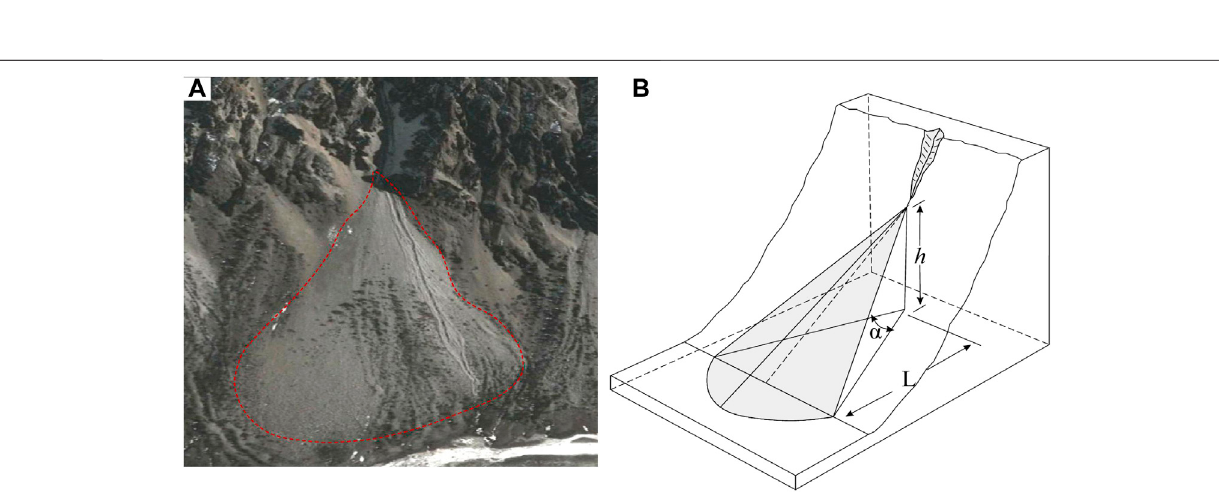
FIGURE 5 | The accumulation morphology and geometric model of triangular prismatic moraines. (A) Field image. (B) Corresponding sketch model.